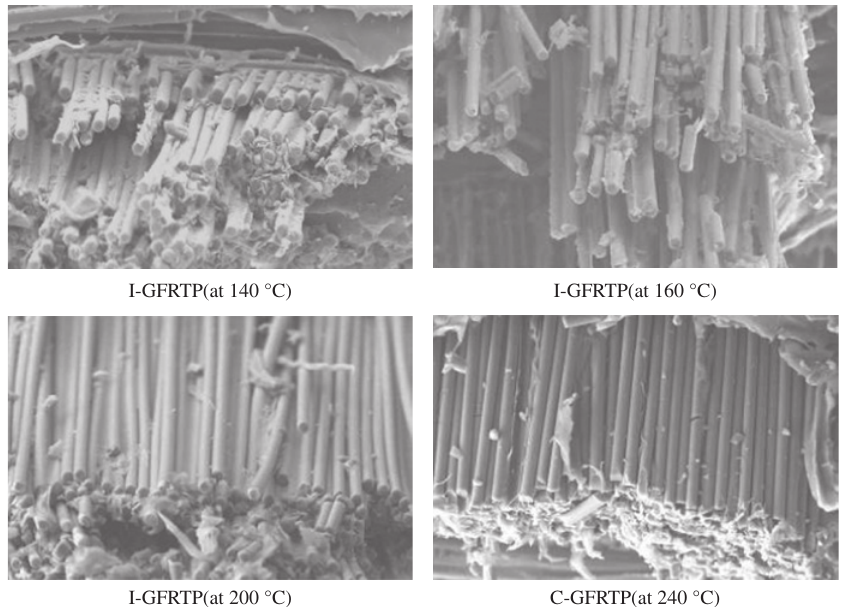
Figure 15 SEM observation of I-CFRTP and C-CFRTP.